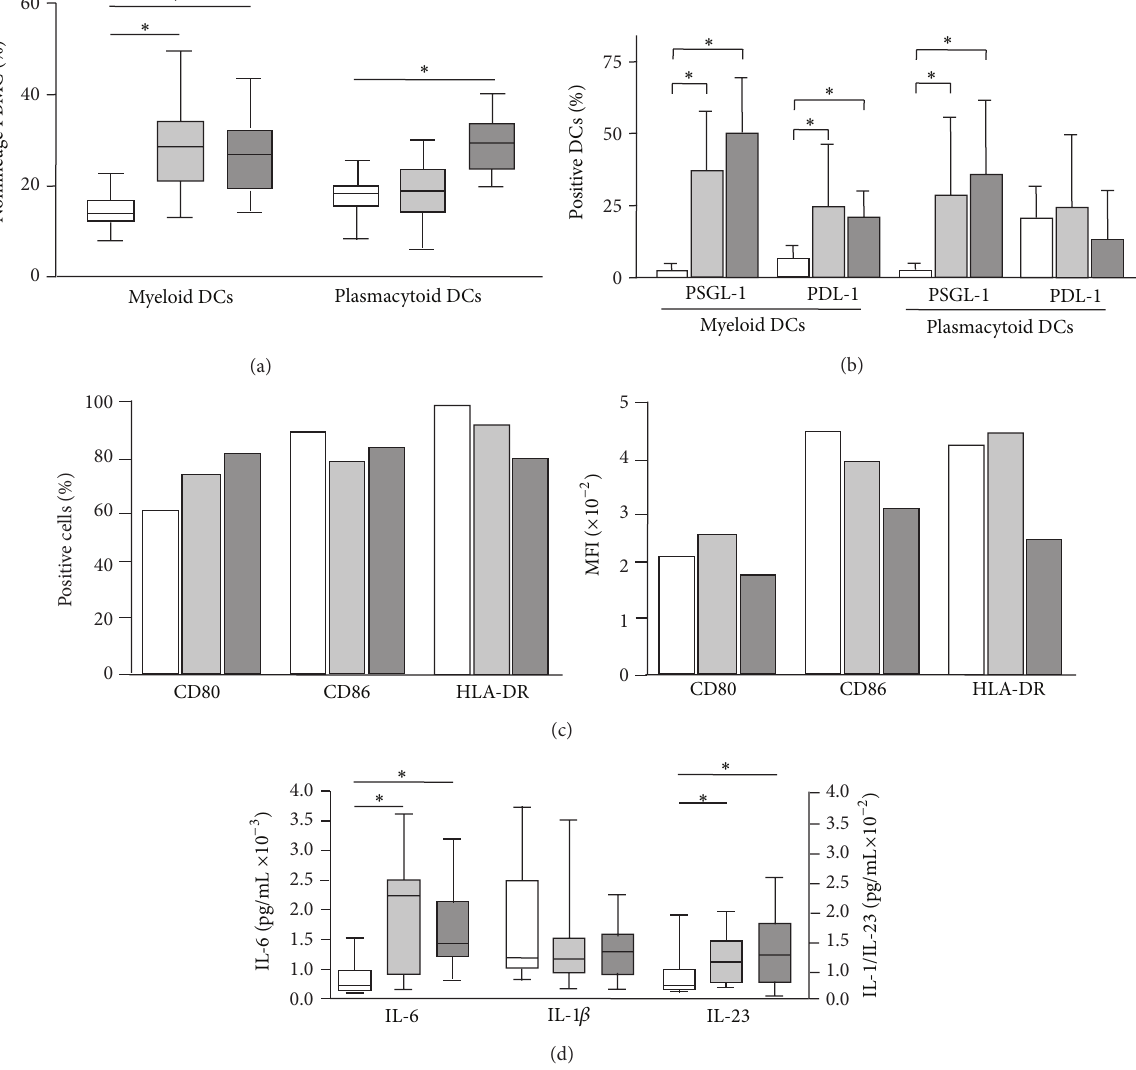
Figure 1: Peripheral blood DCs subsets and mo-DCs in patients with RA and SLE. (a) Myeloid and plasmacytoid DCs levels were determined infreshlyisolatedperipheralbloodmononuclearcellsbymultiparametricflowcytometry,asstatedinmaterialsandmethods.Datacorrespond to the percent of CD11c + BDCA-2+ nonlineage cells (myeloid DCs), and CD11c − BDCA-4+ nonlineage cells (plasmacytoid DCs). (b) The expressionoftheregulatoryreceptorsPSGL-1andPD-1bymyeloidandplasmacytoidDCswasanalyzedbymultiparametricflowcytometryin blood samples from patients with RA and SLE, as stated in materials and methods. (c) mo-DCs were generated in vitro by culturing peripheral blood monocytes in the presence of IL-4 and GM-CSF, and their maturation was induced by LPS. Then, cells were immunostained for the indicated molecules, and analyzed by flow cytometry. Data correspond to the percent of positive cells (left panel), and mean fluorescence intensity (MFI, right panel) in cells from representative patients with RA and SLE, and a healthy control. (d) IL-1 𝛽 , IL-6 and IL-23 were quantified in the cell culture supernatants of mo-DCs incubated in the presence of LPS. Median and interquartile range are shown in (a) and (d) and the arithmetic mean and SD in (c). ∗ 𝑃 < 0.05 . In all panels, white boxes correspond to controls, grey light boxes to patients with RA, and grey dark boxes to SLE patients.